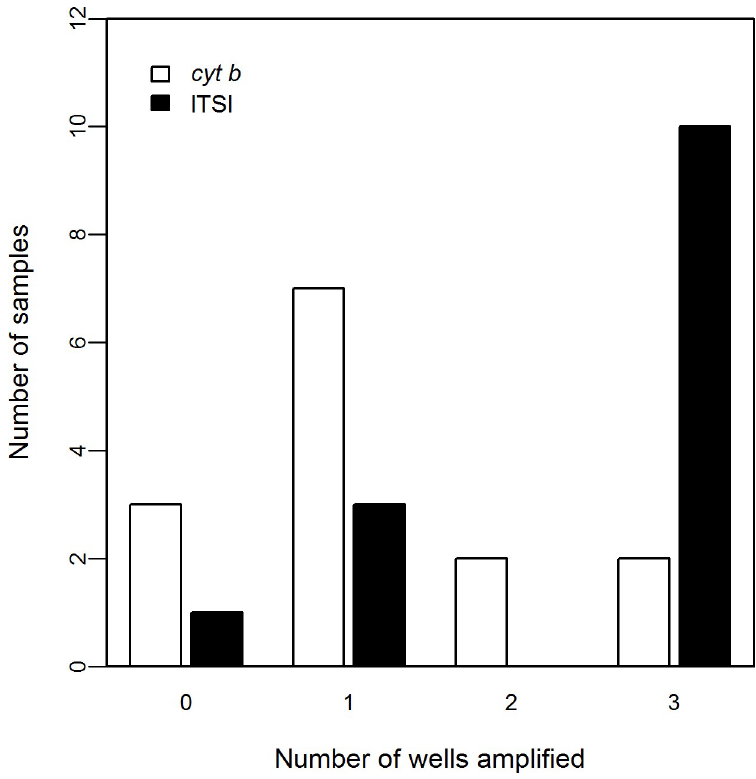
Fig 1. Results of testing environmental DNA samples with assays based in cyt b and ITSI. Fourteen samples from the Range-Wide Bull Trout eDNA Project in the northwestern United States [6] that originally amplified in one of three replicates were retested using the same cyt b assay and a newly designed assay based in ITSI. The ITSI assay had fewer false negatives and more samples that amplified in all three wells when compared to the cyt b based assay.